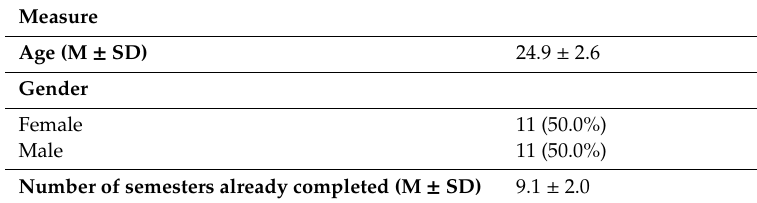
Table 1. Sociodemographic characteristics of the assessed n = 22 medical